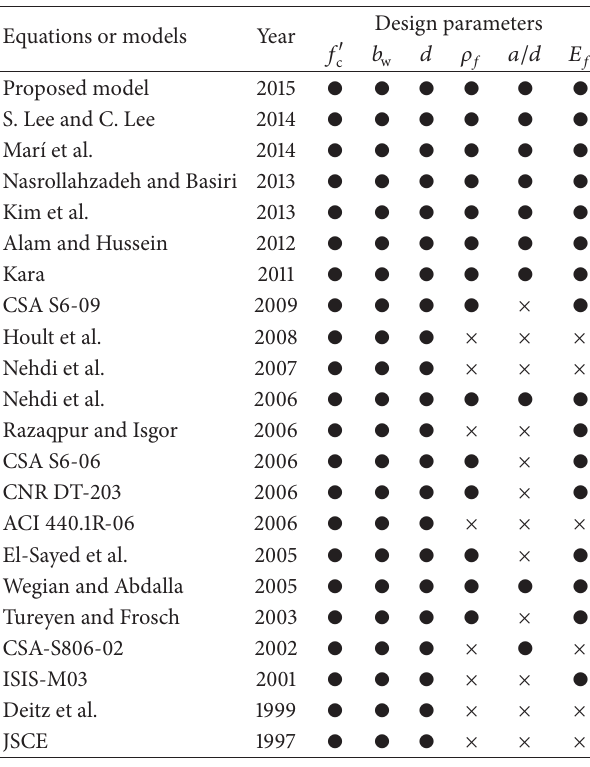
Table 1: Parameter considered in available models and